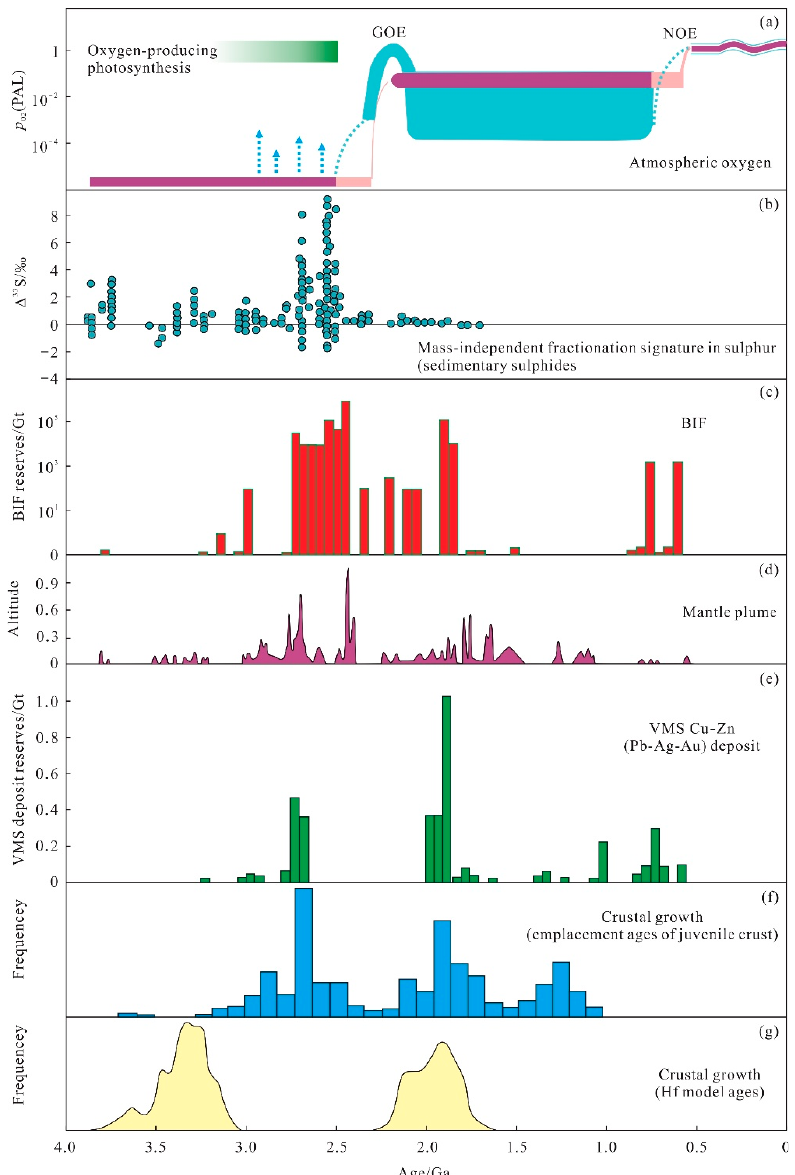
Figure 6. Summary of atmospheric oxygen concentration ( a ), Δ 33 S values of sul fi des ( b ), the age distribution of BIF ( c ), VMS deposits ( d ), mantle plumes ( e ), and juvenile crust ( f , g ) for the Precam- brian era. ( a ) Evolution of Earth’s atmospheric oxygen concentration through time. The purple curve shows a classical, two-step view of atmospheric evolution, while the blue curve shows the emerging model (after [33]). ( b ) Plot of Precambrian Δ 33S values of sul fi des (after [35]). ( c ) Secular trend in the distribution of Precambrian BIF (after [3]). ( d ) Distribution of mantle plumes (after [3]), y -axis (height) is the sum of Gaussian time series for high-Mg intrusive rocks and layered intrusions, fl ood basalts, and dikes. ( e ) The distribution of VMS deposits over time (after [3]). ( f ) Distribution of U- Pb zircon ages for pre-1.0 Ga juvenile crust (after [35]). ( g ) Gaussian probability distribution of Hf model ages for zircons of pre-1.0 Ga (modi fi ed after [35]). In the late Neoproterozoic, studies on C-S-Sr isotopes, iron components, and redox sensitive elements (such as U, Mo, and V) all showed that atmospheric oxygen had un- dergone a second signi fi cant rise (NOE) [32] (Figure 6a). The speci fi c process, starting time, and controlling factors of the event have not been determined. The presence of Ne- oproterozoic BIFs (800 to 600 M years) is closely related to the “Snowball Earth” event